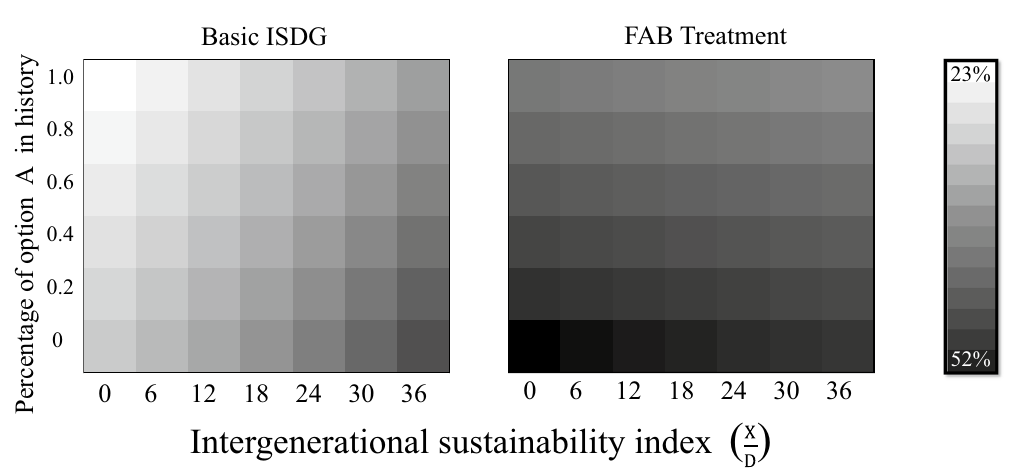
Figure 3. Heat map of the predicted probability of choosing sustainable option B on the domain of the percentage of option A choices in the sequence history and intergenerational sustainability index (